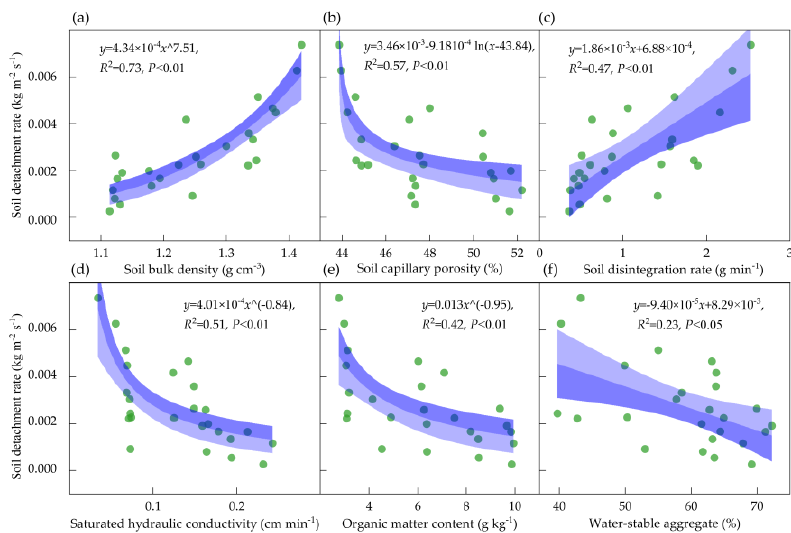
Figure 7. Relationships between soil detachment rate and soil properties. ( a ) Soil bulk density (SBD); ( b ) Soil capillary porosity (SCP); ( c ) Soil disintegration rate (SDR); ( d ) Saturated soil hydraulic conductivity (SHC); ( e ) Organic matter content (OMC); ( f ) Water-stable aggregate (WSA).